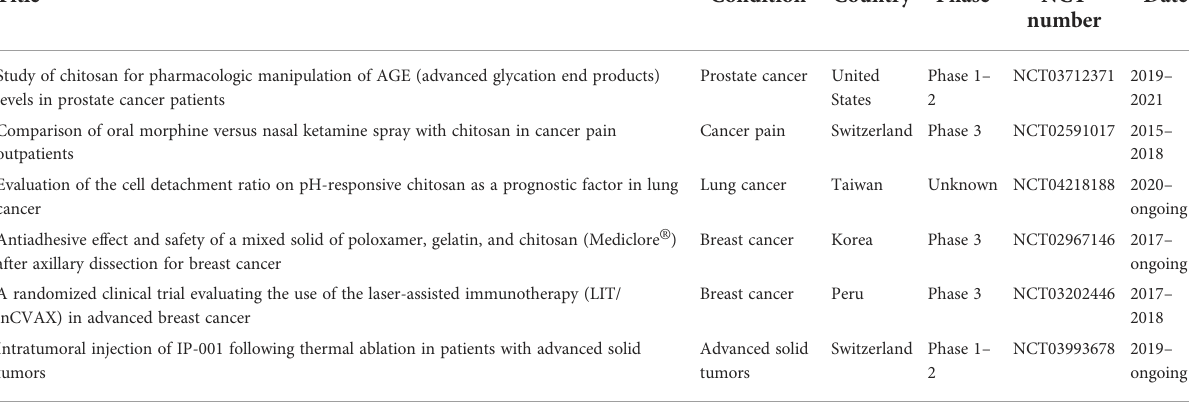
TABLE 1 Chitosan clinical trials for advanced recurrent cancer